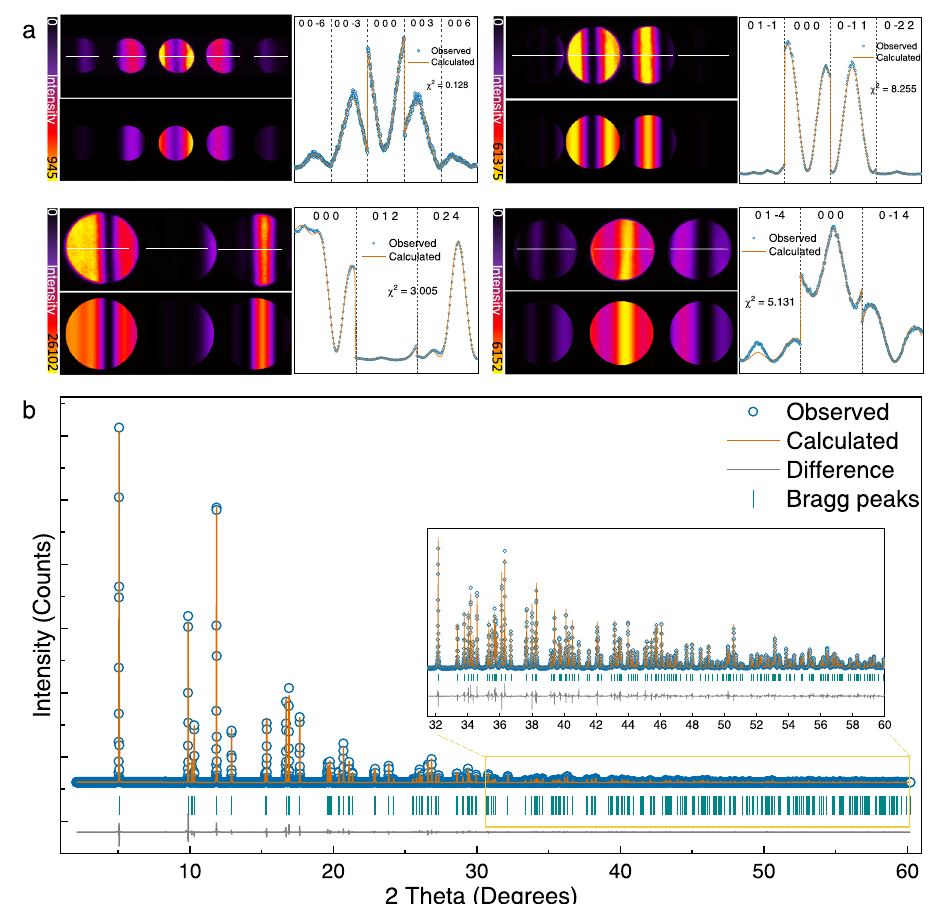
Fig.2|ExtractionofthestructurefactorsofpristineLiCoO 2 .a Measurementsof the low-order structure factors from the energy- fi ltered CBED (003), (006), (0 (cid:1) 11), (012), and (0 (cid:1) 14) systematic rows. The fi rst row on the left side shows the experi- mental CBED patterns. The second row presents the corresponding calculated